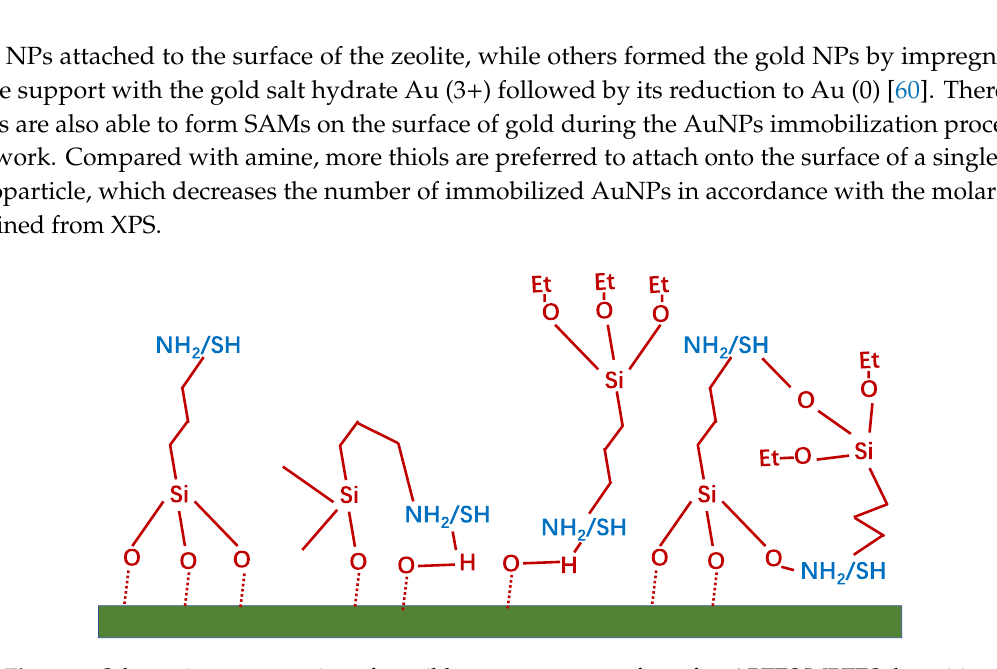
Figure 9. Schematic representation of possible structures on surface after APTES/MPTES deposition.